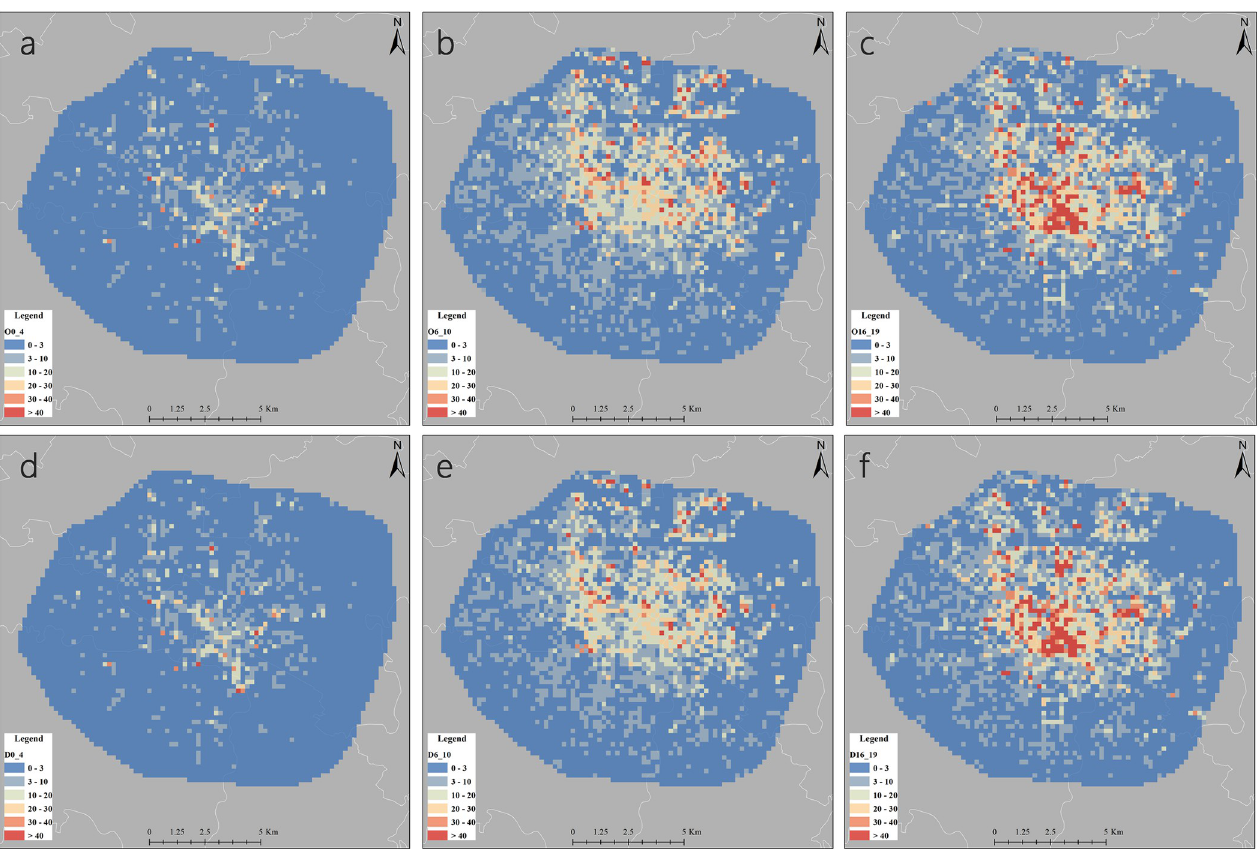
Fig 4. A typical weekday’s average number of pick-ups and drop-offs. a/d: Morning peak 1/Morning peak 2 b/e: Evening peak 1/Evening peak 2 c/f: Late night 1/Late night 2.